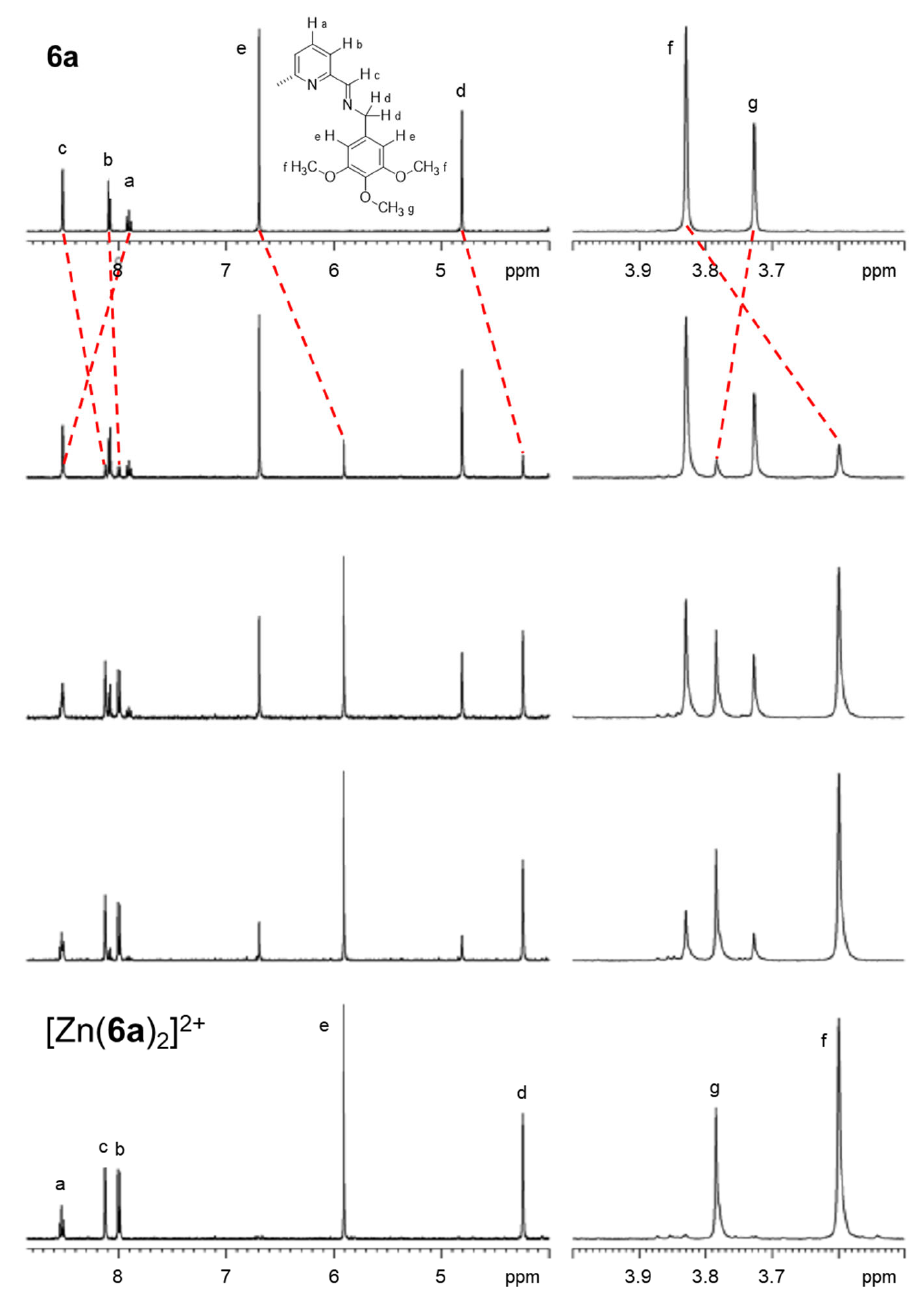
Figure 7. 1 H ‐ NMR spectra of a solution of 6a in CD 3 CN (25 °C, 5 × 10 − 4 M) in the presence of increasing amounts of zinc(II) (0.00, 0.10, 0.25, 0.40, 0.50 equiv. from top to bottom).